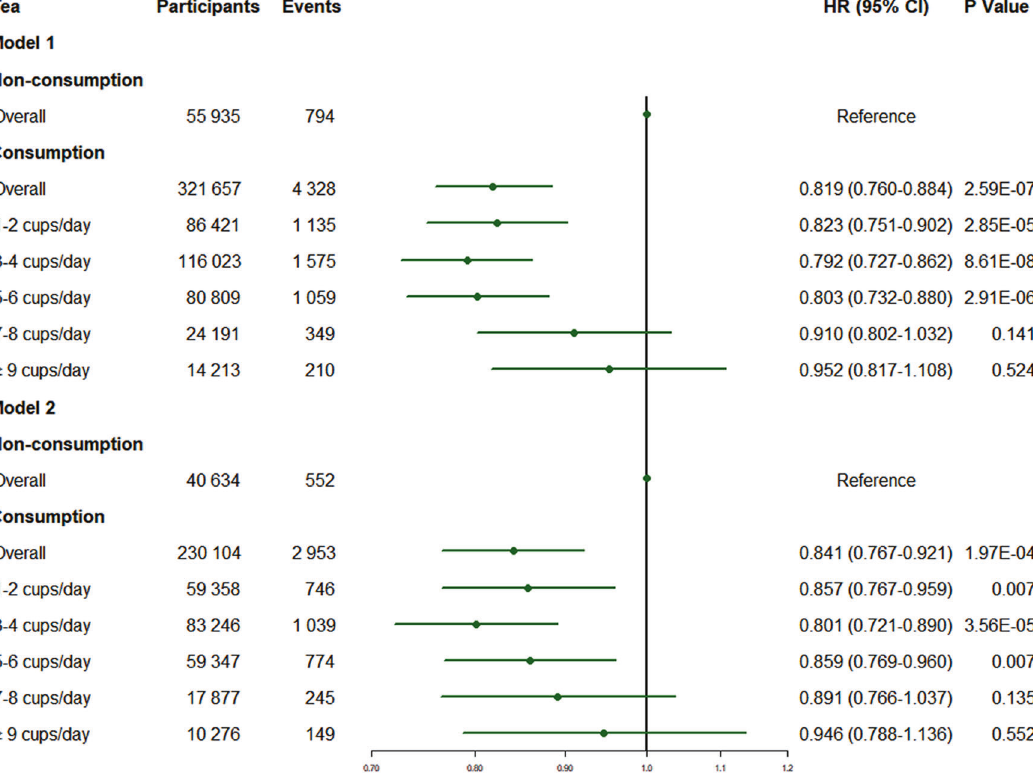
Fig. 2 Association between tea consumption and the risk of incident dementia. In both adjusted models, tea consumption was associated with a reduced risk of dementia (model 1: HR = 0.819 [95% CI:0.760-0.884]; model 2: HR = 0.841 [95% CI: 0.767 – 0.921]). Moderate consumption (1 – 6 cups/day) of tea exerted signi fi cant protective effects. P values were computed by Cox proportional hazard regression. Model 1 was adjusted for age, sex and ethnicity. Model 2 was adjusted for age, sex, ethnicity, TDI, education, BMI, typical sleep duration, smoking